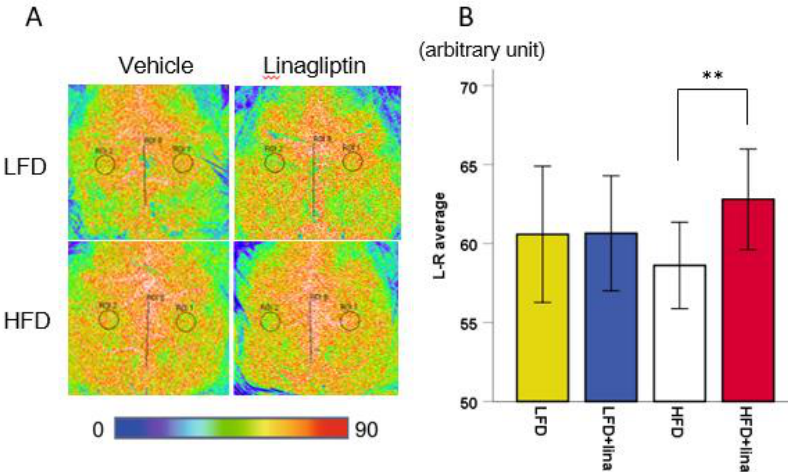
Figure 2. Effects of linagliptin (10 mg/kg BW/day) on cerebral blood flow (CBF). Linagliptin restored CBF reduction. (A) Representative images showing CBF measured by laser speckle flowmetry in vehicle-treated mice (left) and linagliptin-treated mice (right) at 7 months of age. ( B ) A histogram showing CBF. Error bars indicate ± SD, ** p < 0.01.